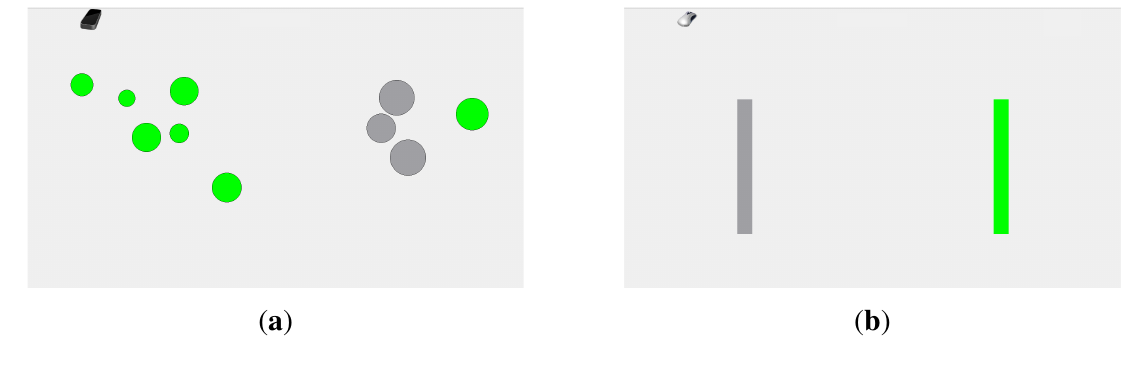
Figure 3. Scaled illustrations of the graphical user interface. Selected targets are displayed in gray; selectable targets are colored green: ( a ) the additional custom-designed training phase for the LMC pointing task; and ( b ) the interface for the pointing